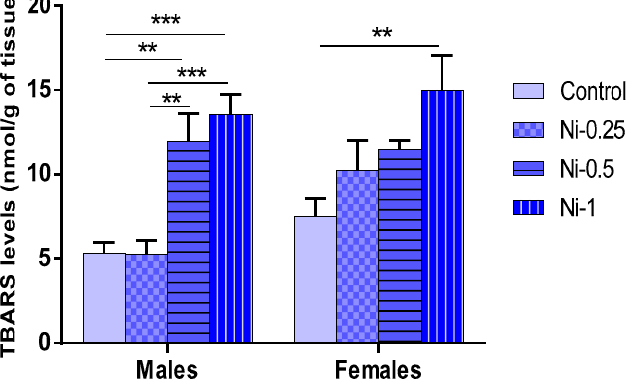
Figure 6. Determination of the lipid peroxidation levels in hippocampus, TBARS levels expressed in nmol/g of tissue in male and female rats after 8 weeks of treatment with 0.9% of NaCl (Control), 0.25 mg/kg (Ni-0.25), 0.5 mg/kg (Ni-0.5), and 1 mg/Kg (Ni-1) of Ni. Results are represented as mean ± SEM. The significance level is 0.05. ** p < 0.01, *** p < 0.001.